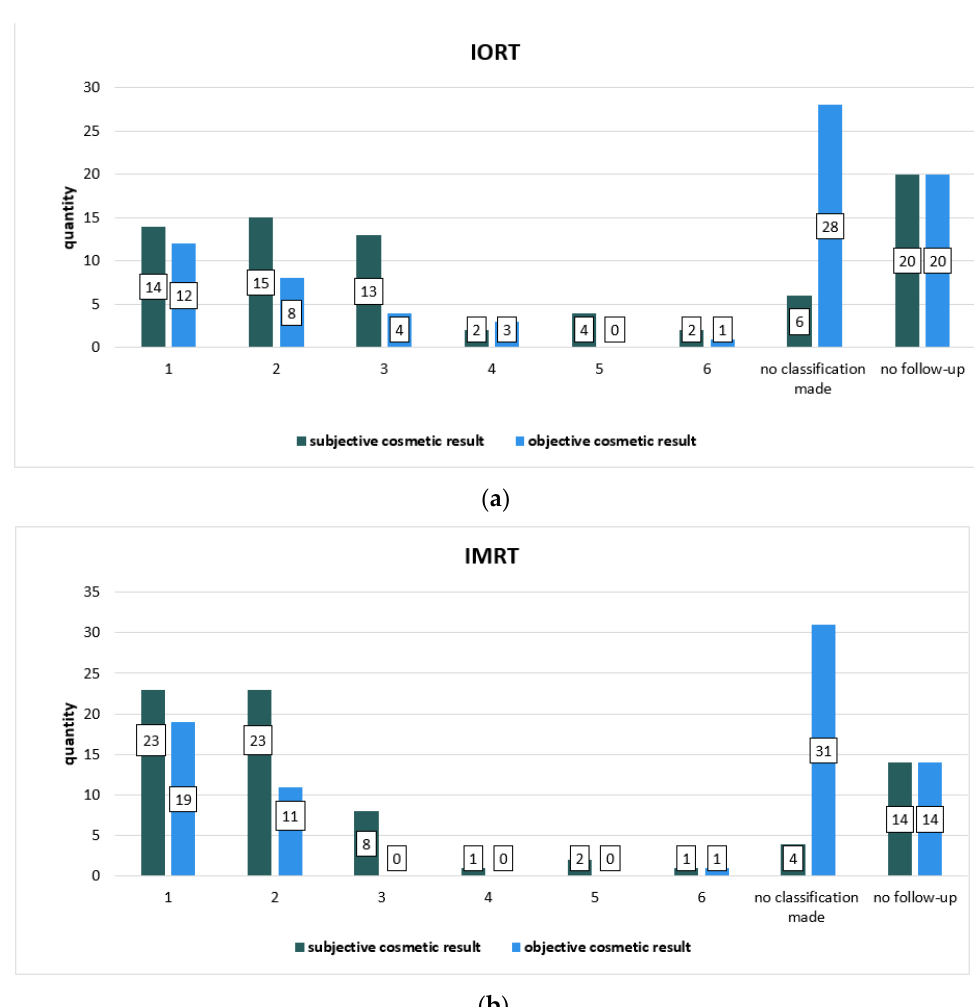
Figure 2. Graphic representation of the comparisons of subjective cosmetic results evaluated by patients during radiotherapy series and objective cosmetic results evaluated by physicians during radiotherapy series divided into subgroups: ( a ) for IORT and ( b ) for IMRT subgroups. The columns represent the number of cases.